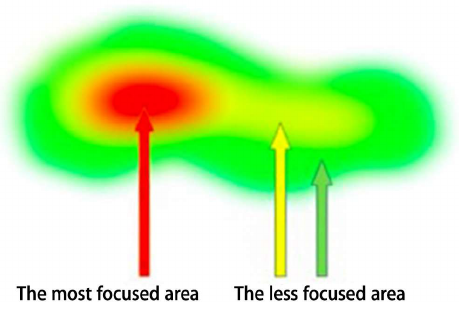
Figure 3. Schematic diagram of a heat map.